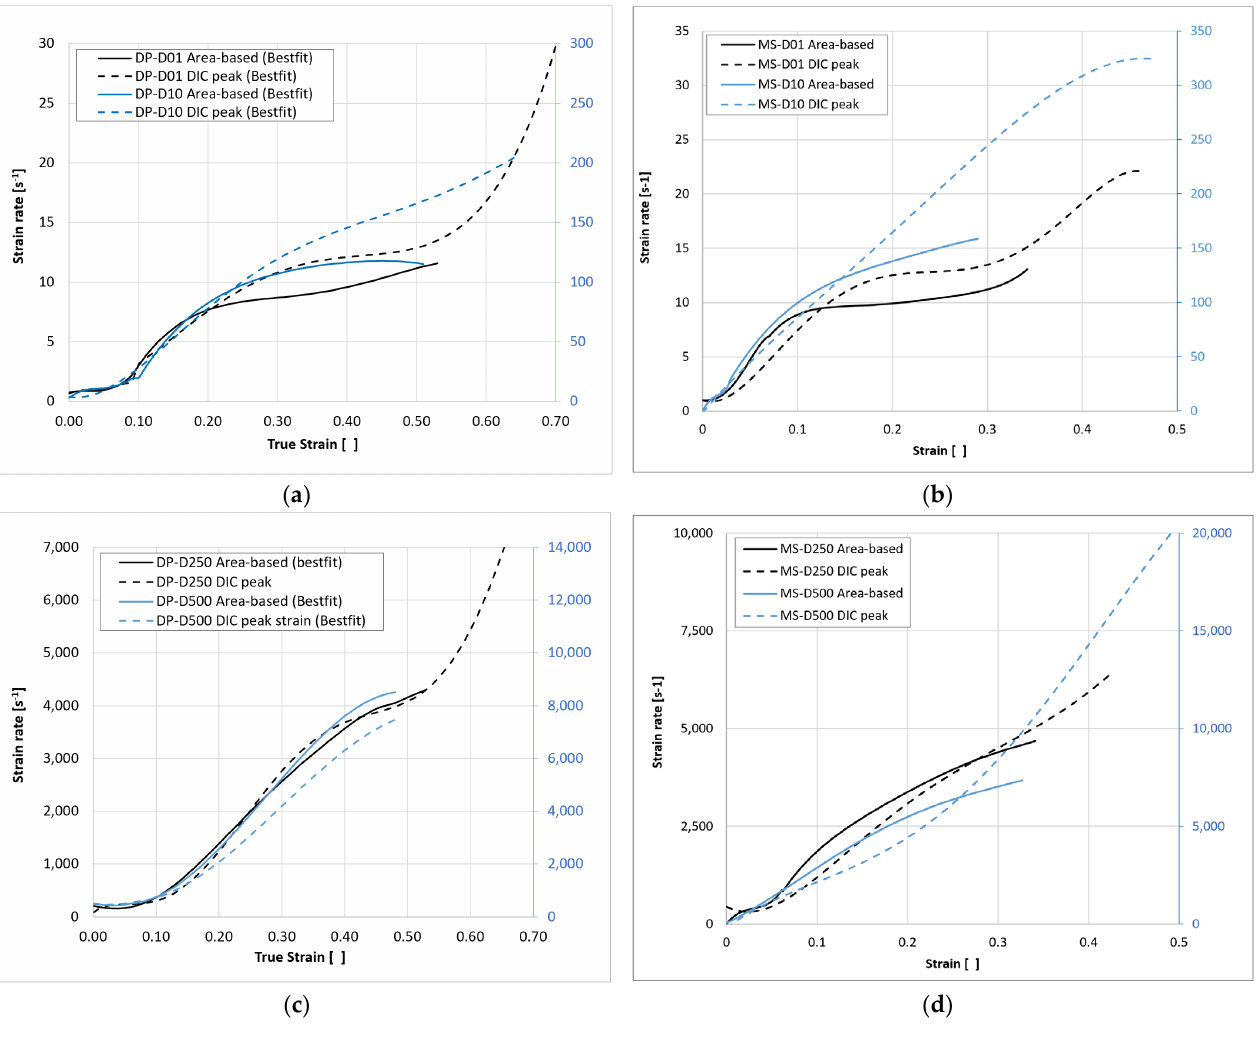
Figure 20. Strain rate histories of dynamic tests at intermediate (( a ) DP, ( b ) MS) and high strain rates (( c ) DP, ( d ) MS).